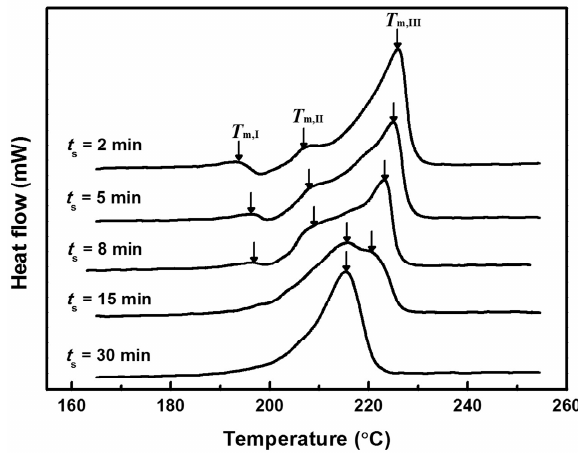
Figure 4. DSC heating thermograms of blend samples crystallized isothermally at 155 °C for 1 h after annealing at 265 °C for t s .